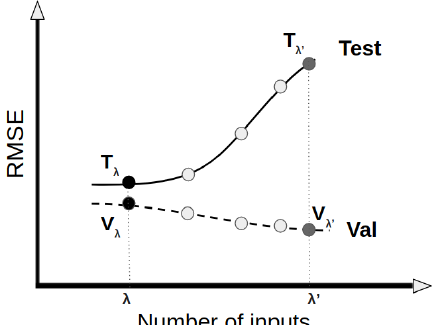
Figure 4. Schematic illustration of validation and testing RMSE values of predicted yield anomalies for an increasing number of inputs, obtained from the LTO procedure. For a fixed complexity level, i.e. n input = λ , two RMSE values are obtained: V λ for val- idation and T λ for testing datasets. (The cases of underfitting are excluded in this